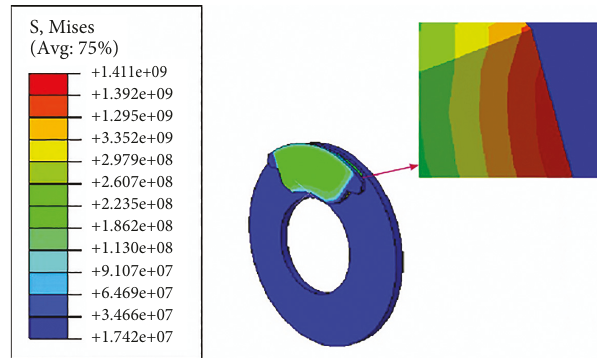
Figure 9: Contour plot of von Misses stress distribution without temperature